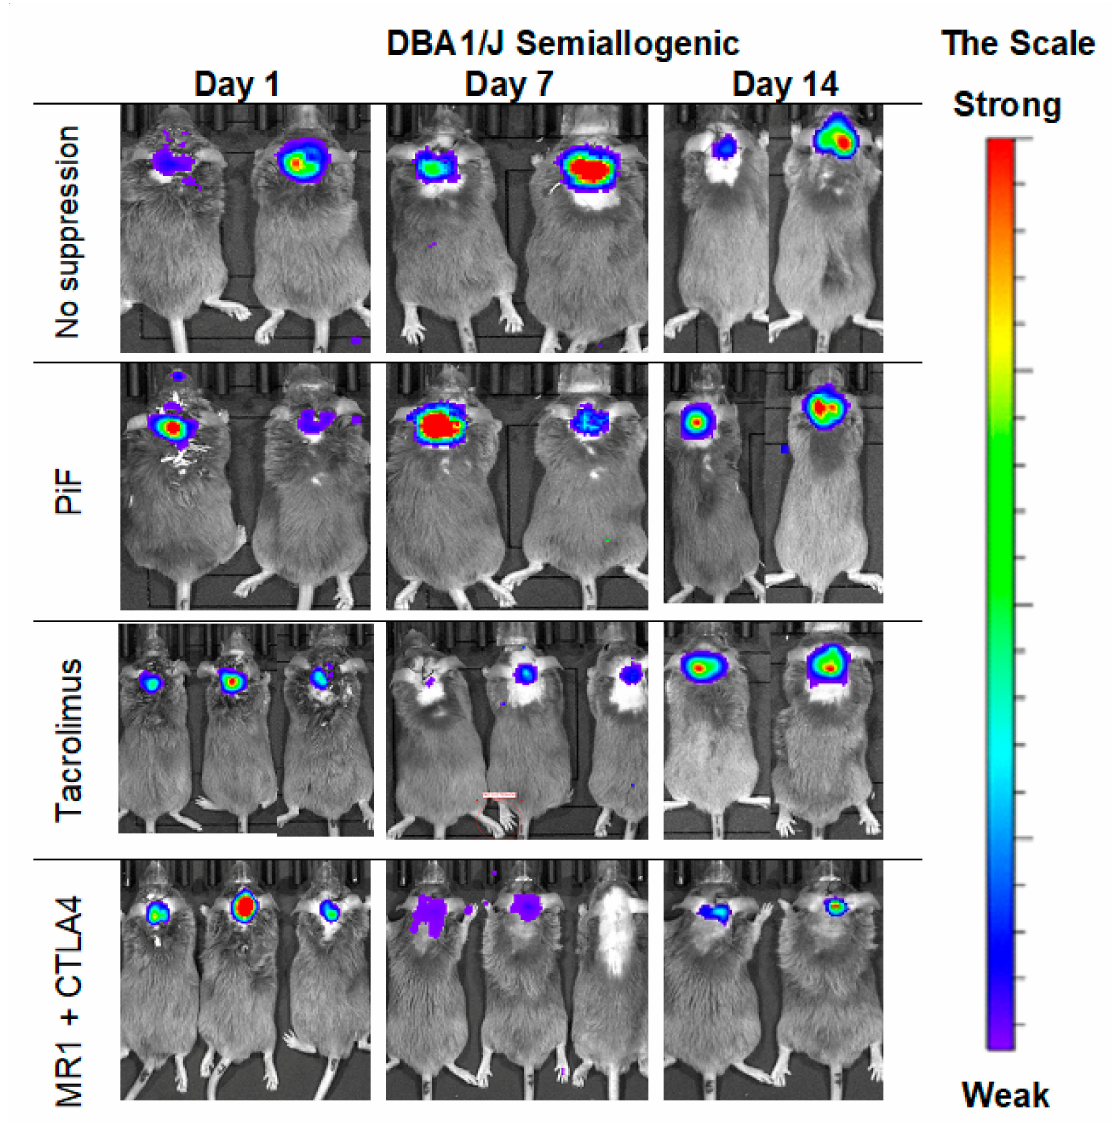
Figure 5. Representative pictures of the murine GRP graft survival after transplantation into semiallogenic DBA1 mouse model: The BLI signal from the graft was measured on days 7 and 14 post-transplantation. Abbreviations: BLI- bioluminescence imaging; GRP-glial-restricted progenitor